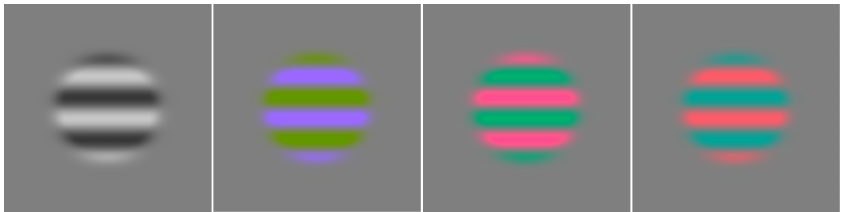
Figure 2. High-contrast versions of the achromatic, S-, M-, and L-cone type Gabor patches with a spatial frequency of